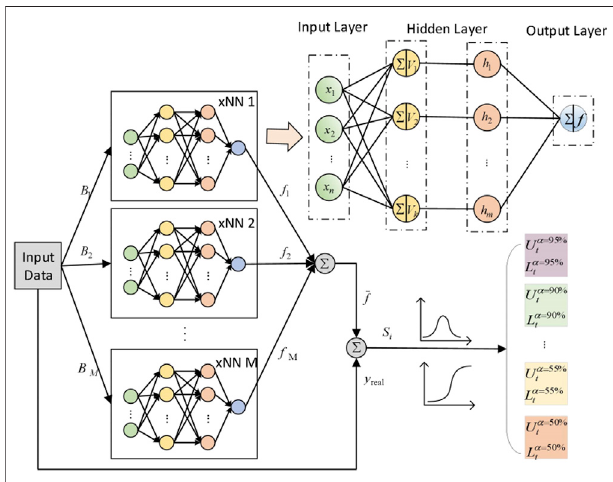
FIGURE 1 | Probabilistic forecasting framework based on